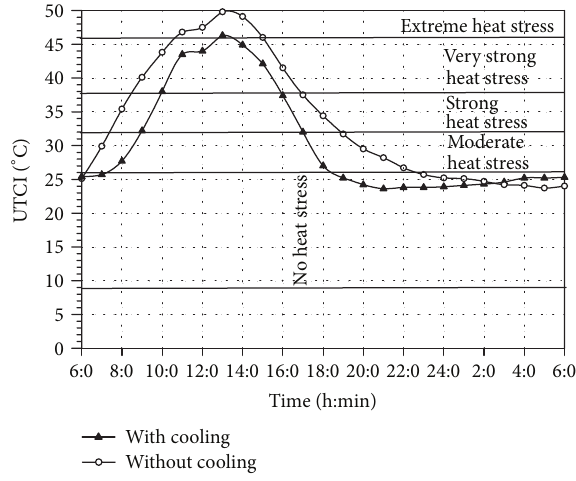
Figure 7: Time course of the universal thermal climatic index (UTCI) estimated in the greenhouse with and without cooling of the inside